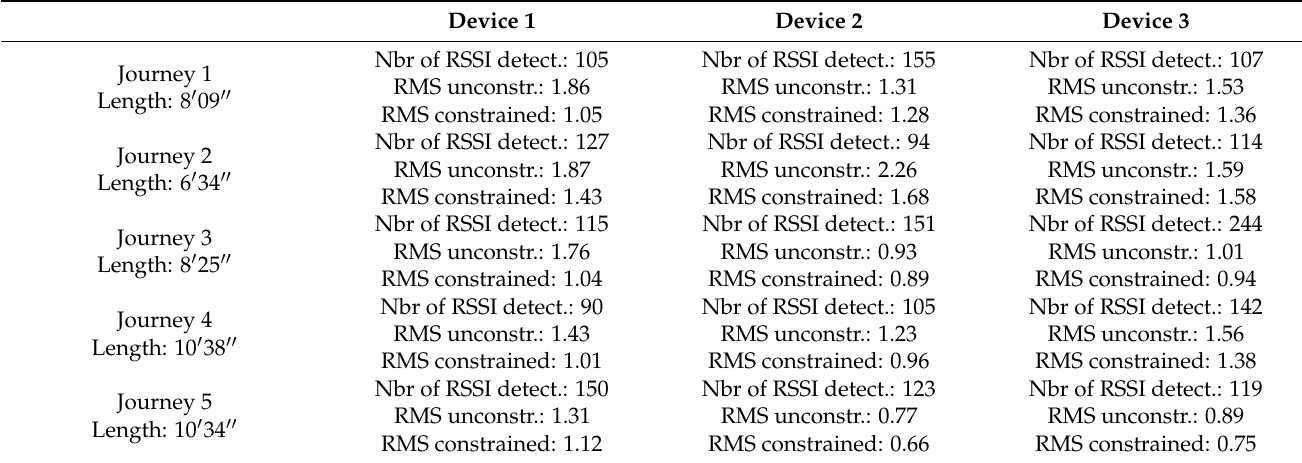
Table 1. RMS localization errors (in m) with and without constraint